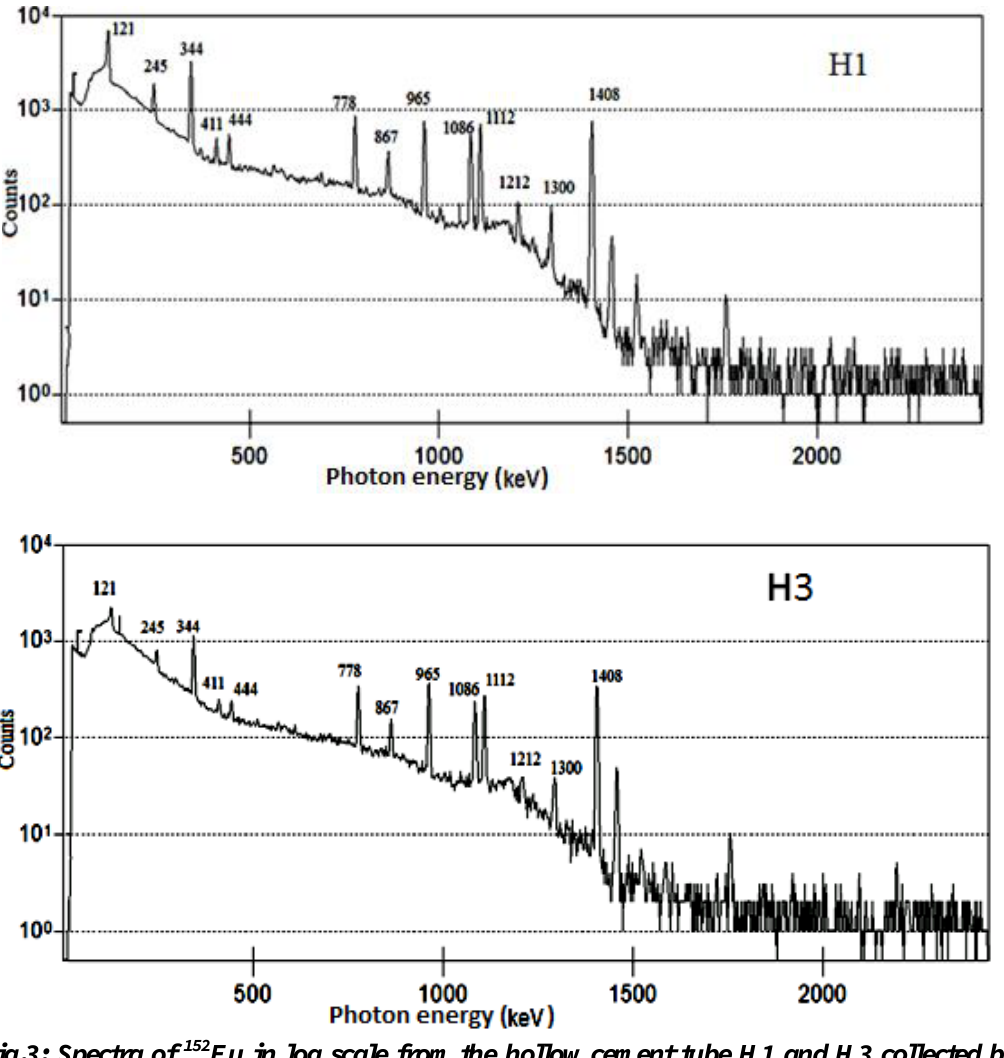
Fig.3: Spectra of 152 Eu in log scale from the hollow cement tube H1 and H3 collected by scanning system within 1800sec counting